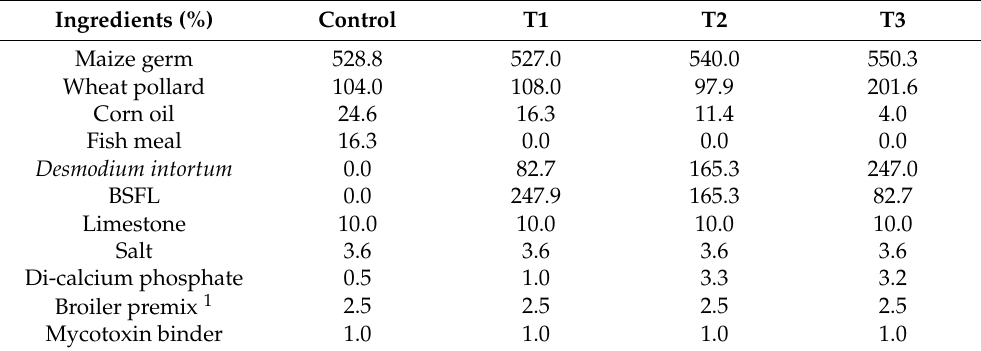
Table 2. Feed composition for broiler chicken starter (Diets (g/kg) as fed) of experimental diets. Ingredients